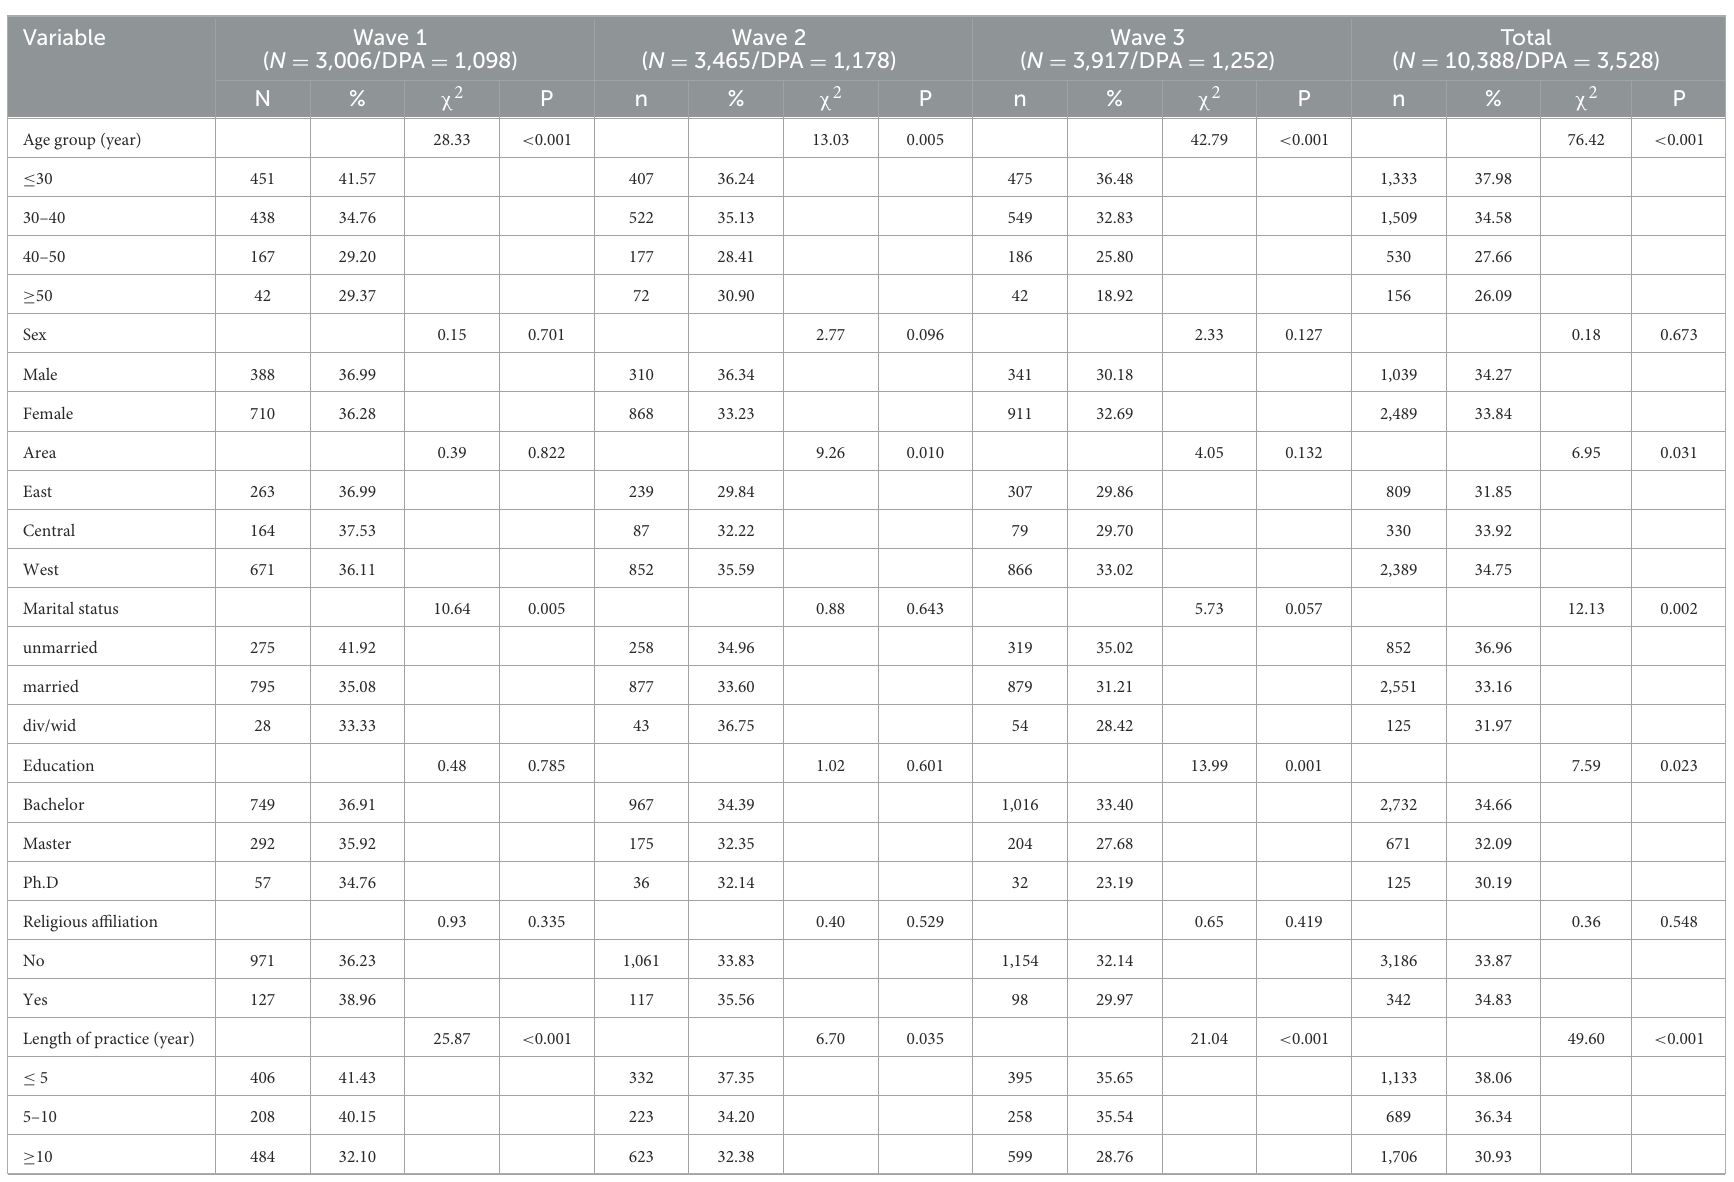
TABLE 2 Epidemiological distribution of the prevalence of declined personal